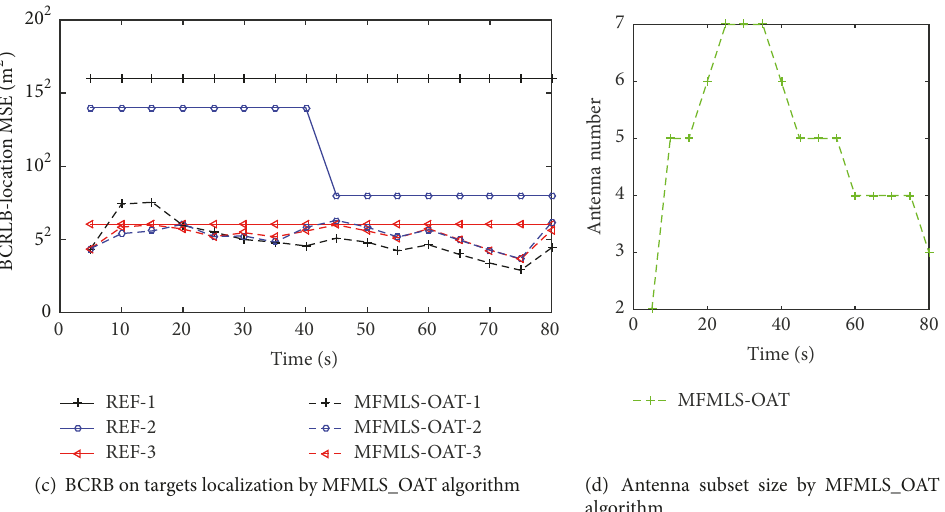
(b) Antenna subset size by MFMLS algo- rithm